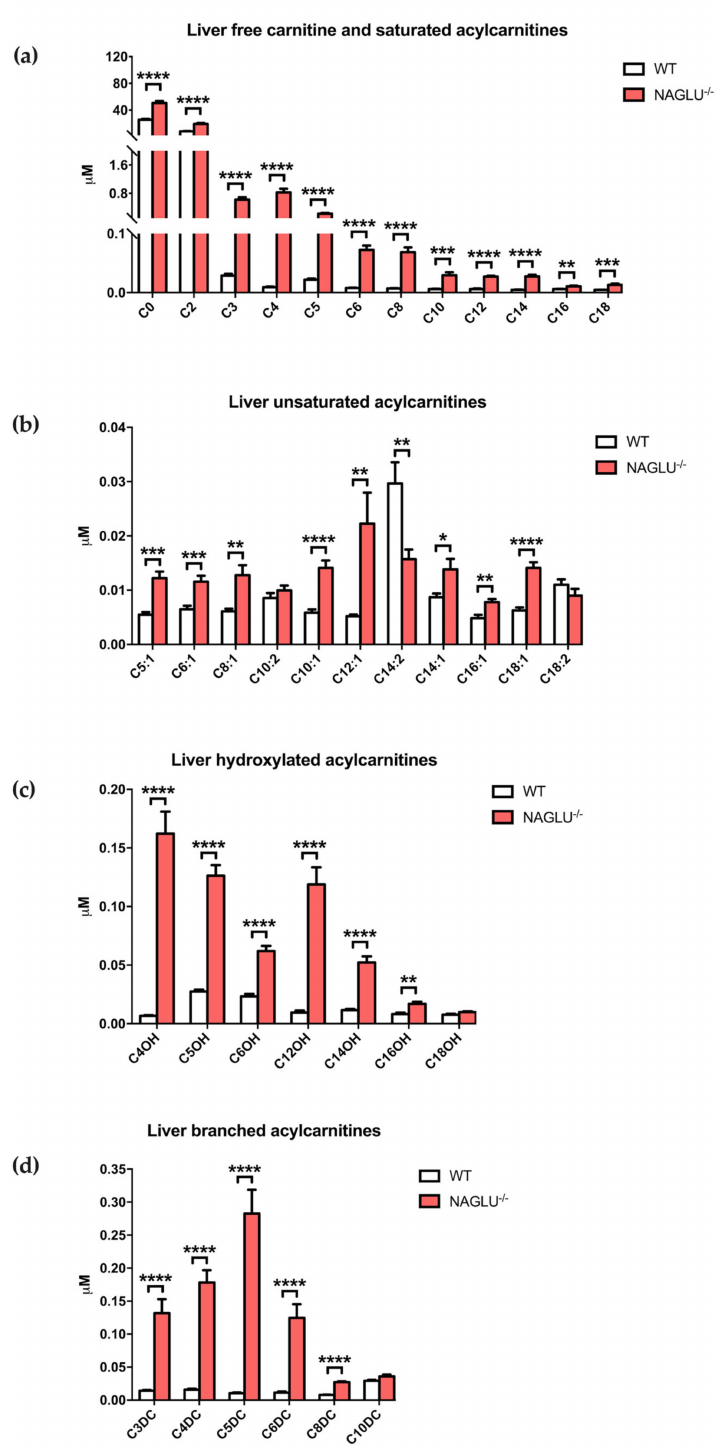
Figure 7. Liver-specific accumulated acylcarnitines in NAGLU − / − mice: free carnitine and saturated acylcarnitine ( a ), unsaturated acylcarnitine ( b ), hydroxylated acylcarnitine ( c ) and branched acylcarnitine ( d ). Results are represented as the mean ± standard error of the mean (SEM). The statistical significance of the di ff erence in metabolite tissue concentrations between genotype conditions (NAGLU − / − and WT) was evaluated by parametric or non-parametric tests when data failed the Shapiro–Wilk normality test. * p < 0.05, ** p < 0.01, *** p < 0.001, **** p <